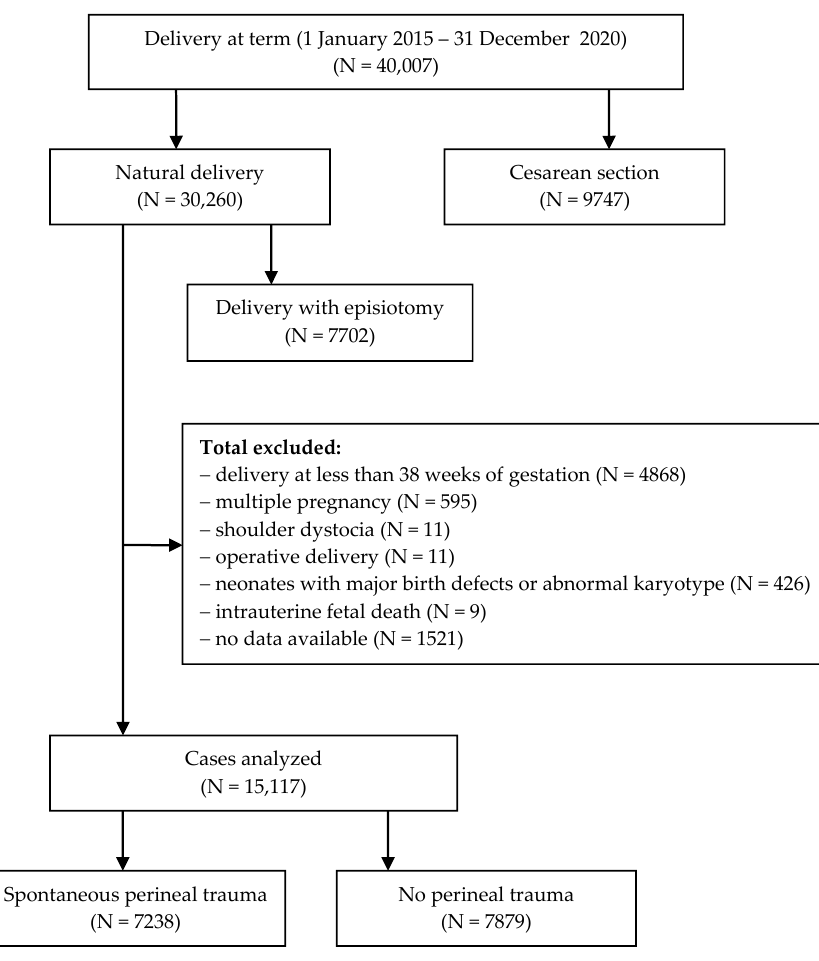
Figure 1. Flow diagram of exclusions and final analytic sample.